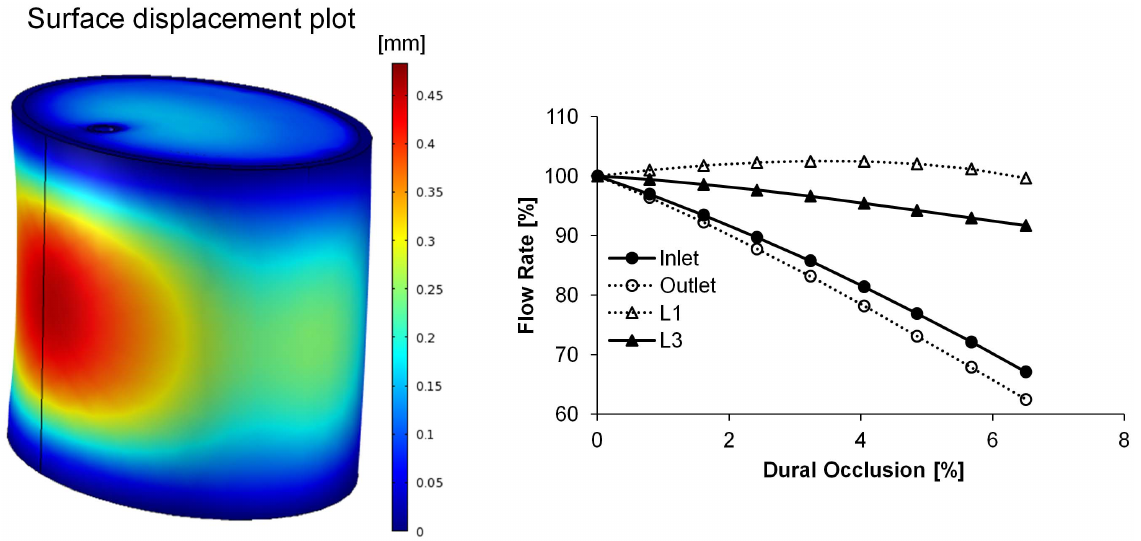
Figure 2. (Left) Representative surface plot of cervical spinal cord displacement under anterior loading. Colorimetric scale represents the induced displacement [mm]. (Right) Retained volumetric blood flow rate under anterior loading. The effect of anterior spinal compression on ASA and branch (L1 and L3) blood flow rates was assessed over the range of 0–6.5% dural occlusion, and the resultant change in arterial blood flow rates were calculated based on the percent of the baseline value (blood flow rate with no compressive loading).